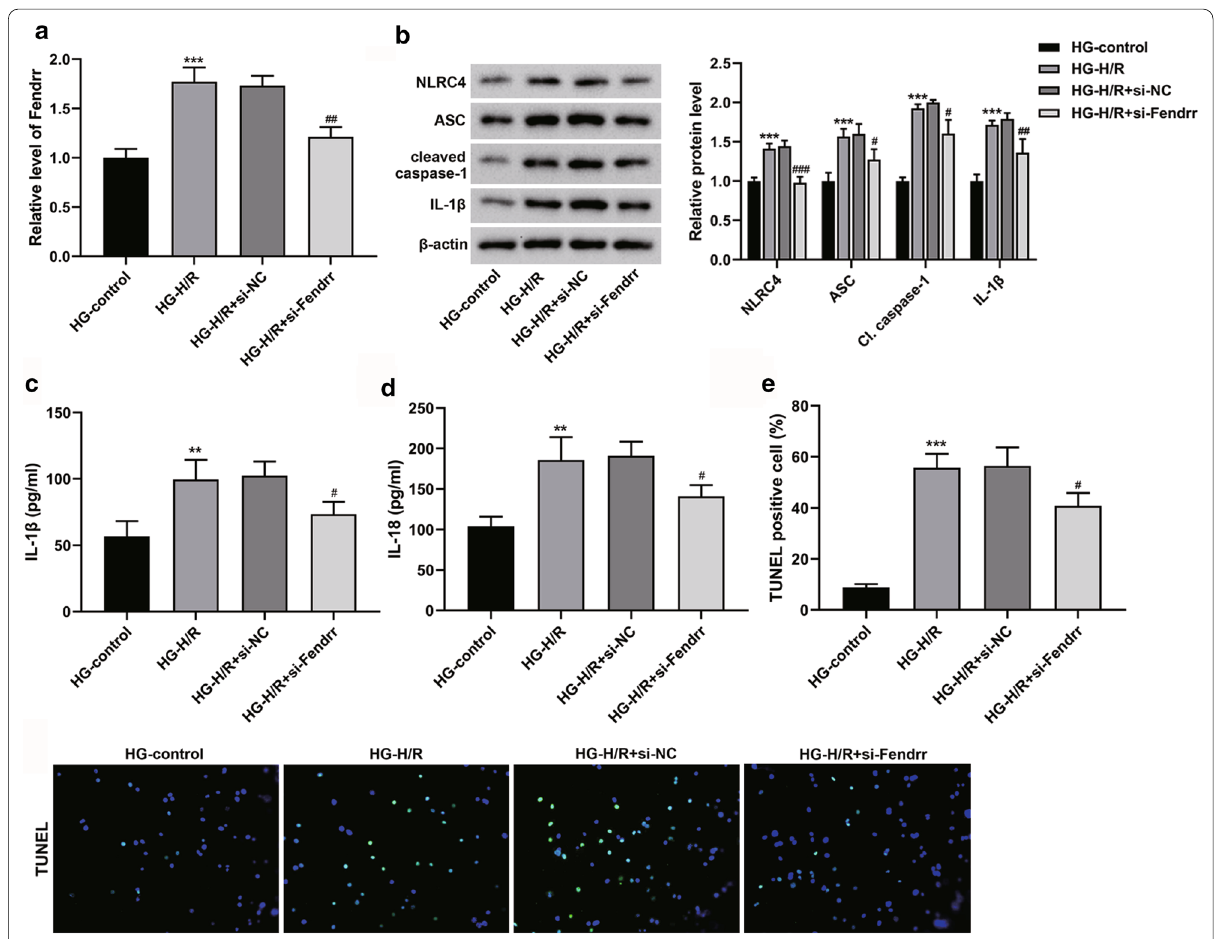
Fig. 2 Interfering Fendrr inhibits NLRC4‑mediated pyroptosis of the high glucose (HG)‑hypoxia/reoxygenation (H/R) model cells. Exposing mouse microglia cell line BV‑2 cells to high glucose followed by H/R, and the cells were transfected with si‑Fendrr or si‑NC (control). The cells were divided into the HG‑control group, the HG‑H/R group, the HG‑H/R si‑NC group, and the HG‑H/R si‑Fendrr group (n 3/group). a The expression of + + = lncRNA‑Fendrr was detected by qRT‑PCR. b NLRC4, ASC, cleaved caspase‑1 and IL‑1β protein levels were detected by Western blotting. c and d The levels of IL‑1β and IL‑18 in the cell supernatant were measured by ELISA. e TUNEL analysis was performed on the cells. Data are presented as means SD. P values were analyzed by Student’s t‑test. ** P < 0.01 and *** P < 0.001 versus the HG‑control group; # P < 0.05 and ### P < 0.001 versus ± the HG‑H/R